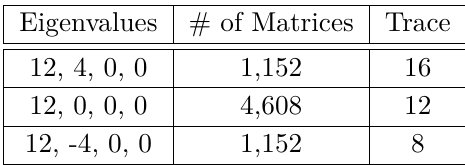
Table 25 . Eigenvalue equivalent classes of 6,912 distance matrices in class